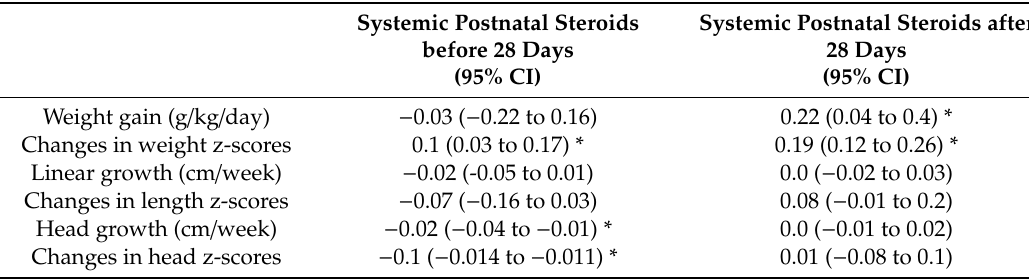
Table 2. Adjusted e ff ect of postnatal systemic steroids on the growth parameters of preterm infants < 32 weeks of gestational age according to the timing of systemic steroid administration. Regression models are adjusted by gestational age, sex, invasive mechanical ventilation at 28 days, moderate–severe BPD, length of stay, and z-score at birth for weight, length or head circumference. Changes in z-scores refer to changes in z-score from birth to